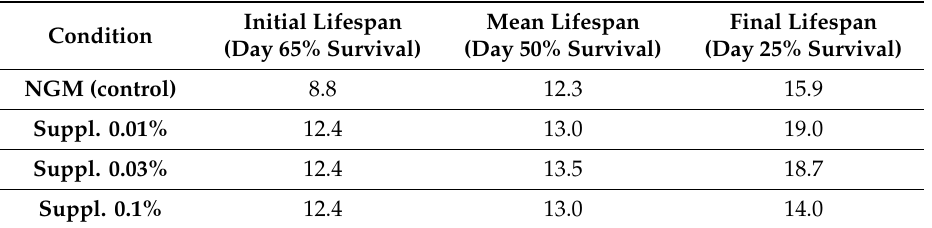
Table 3. E ff ect of supplement on the initial, mean and final